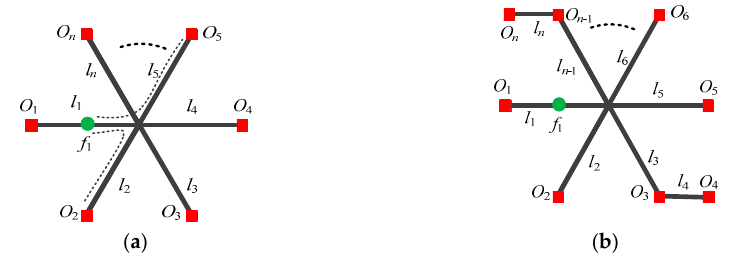
where, 𝑙 (cid:3042) represents the distance between O i and the assumed fault location ( 𝑙 (cid:3027) ), which is also (cid:3284) ,(cid:3039) (cid:3275) shown as the dotted line in Figure 4a.